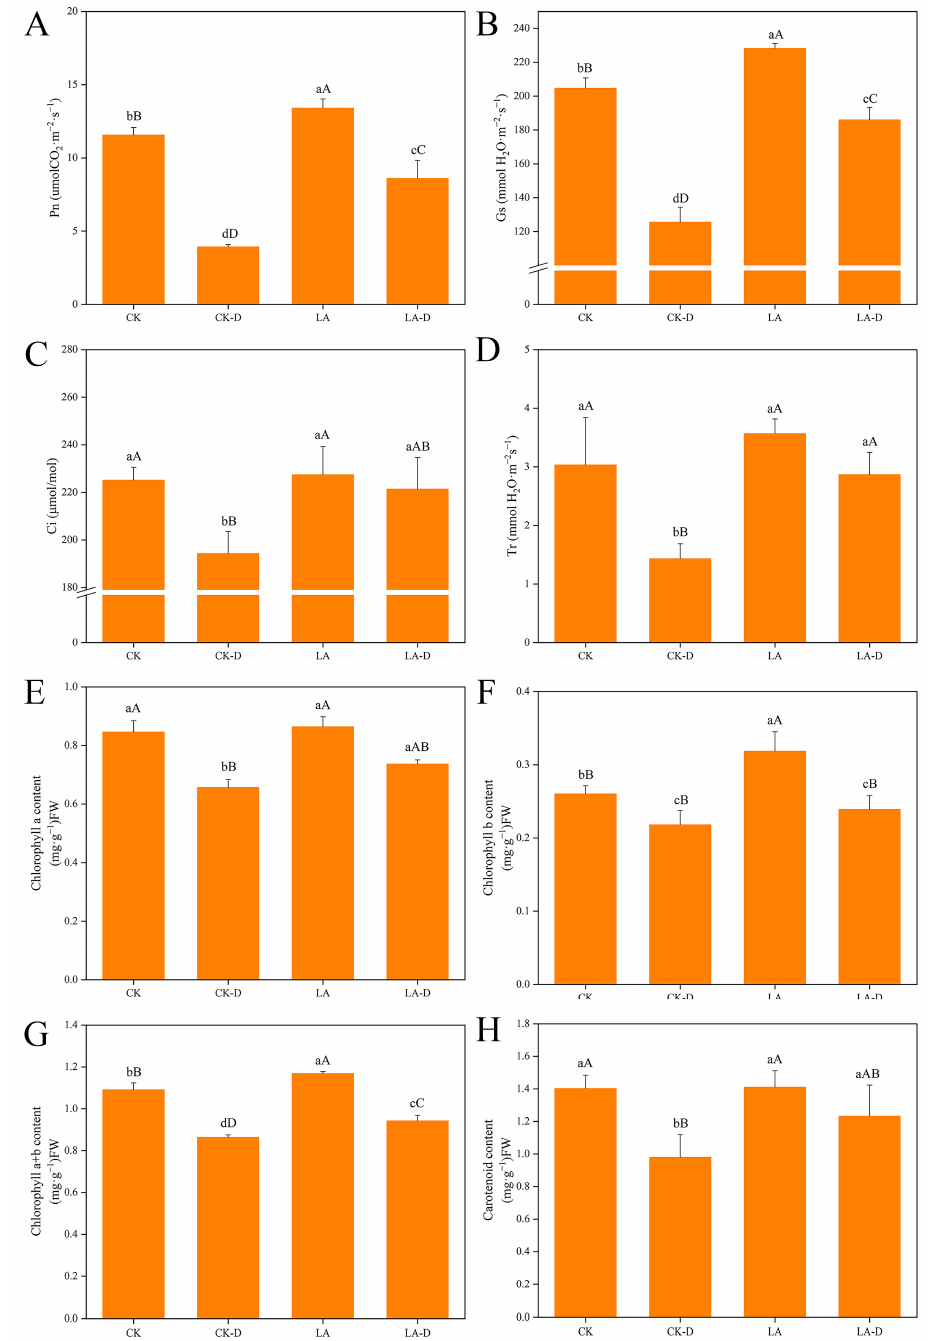
Figure 2. The effects of LA pretreatment on photosynthesis and chlorophyll content in drought-stressed P. persica . ( A ) net photosynthetic rate (Pn), ( B ) stomatal conductance (Gs), ( C ) intercellular carbon dioxide concentration (Ci), ( D ) transpiration rate (Tr), ( E ) chlorophyll a content (Chl a), ( F ) chlorophyll b content (Chl b), ( G )total chlorophyll content (Chl a + b), ( H ) carotenoids (Car). Values represent means ± SD of three replicates. Di ff erent le tt ers indicate signi fi cant di ff er- ences according to Duncan’s multiple range tests.